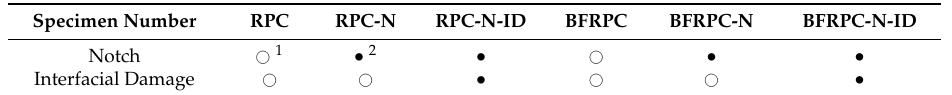
Table 4. Description of test beam conditions.